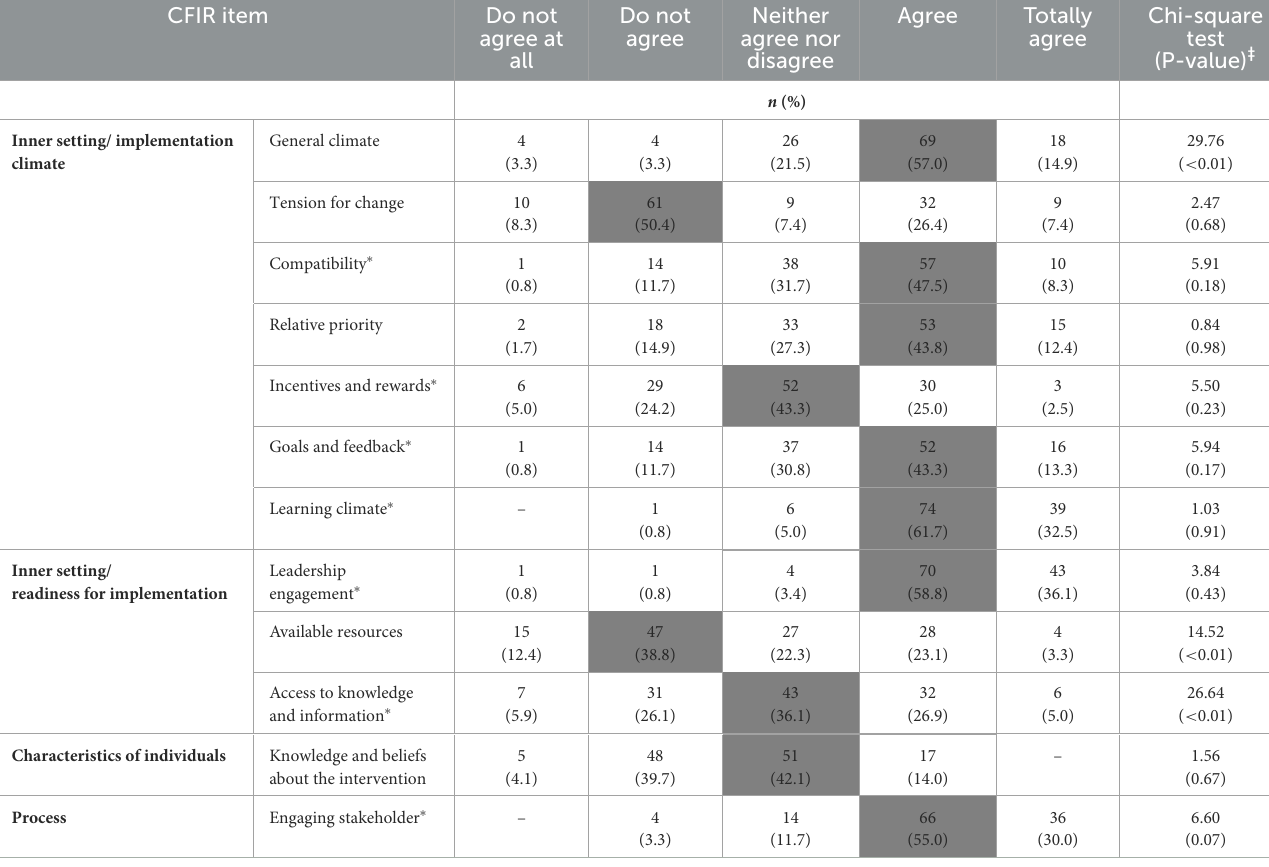
TABLE 3 Descriptive and bivariate analyses of CFIR determinants with policy adoption ( n = 121